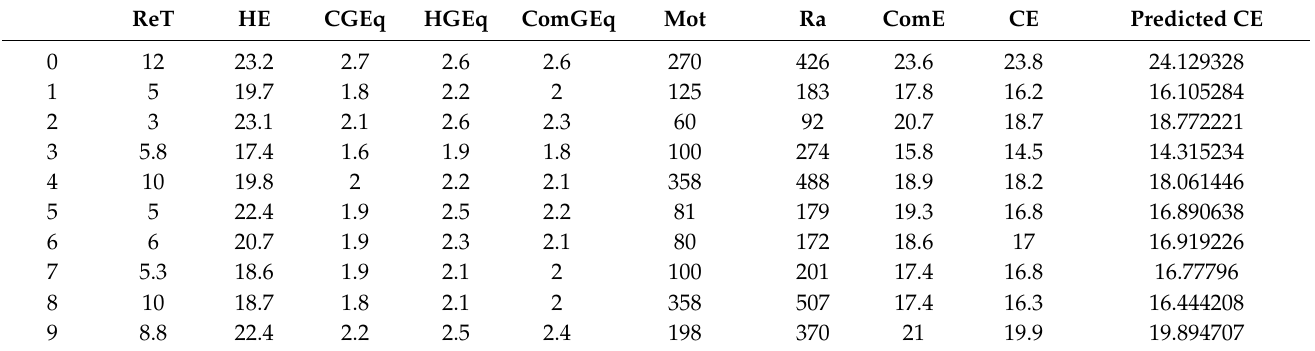
Table 3. Predicted and desired city electric charge consumption.